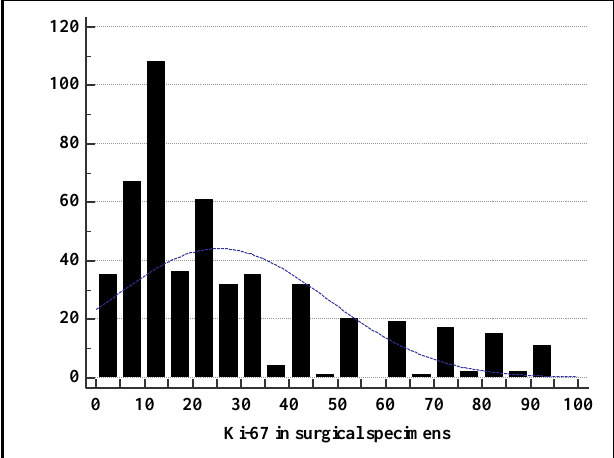
Figure 1: Histogram showing the distribution of Ki-67 expression in 498 early breast cancer patients Survival Analysis After a median follow up time of 24.6 months disease and only 6 (1.2%) patients